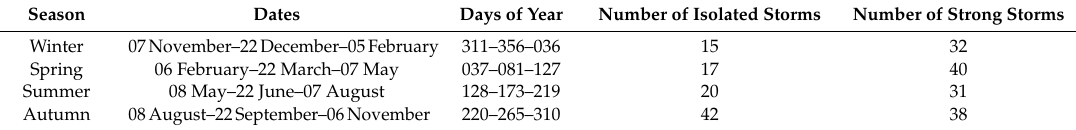
Table 2. Beginnings and ends of the seasons and numbers of storms per season.